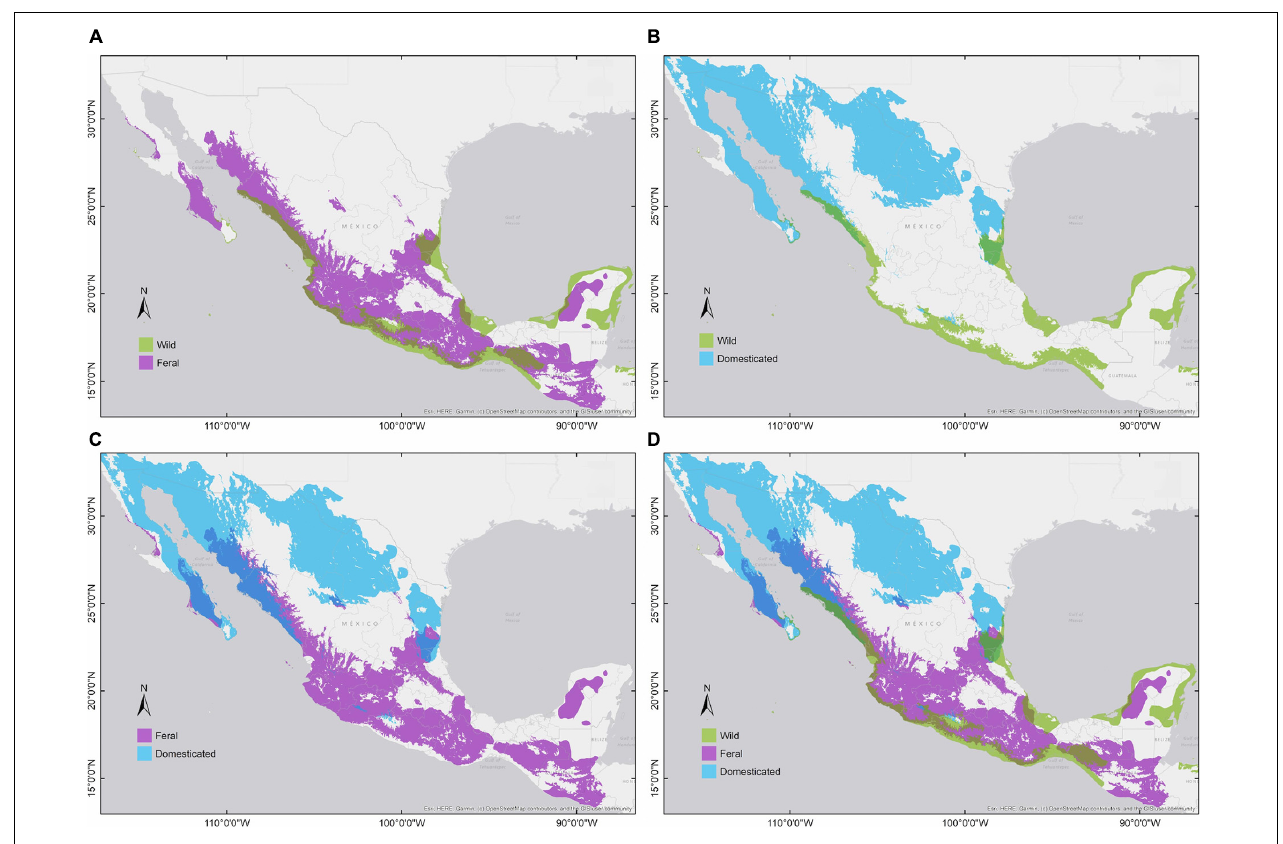
FIGURE 3 | Binary environmental suitability models comparing the extent of the potential distribution of members of G. hirsutum wild-to-domesticated complex (colors indicate suitability: wild = green, feral = magenta, and domesticated = blue). (A) Wild vs. feral; (B) wild vs. domesticated; (C) feral vs. domesticated; and (D) the three cotton groups.